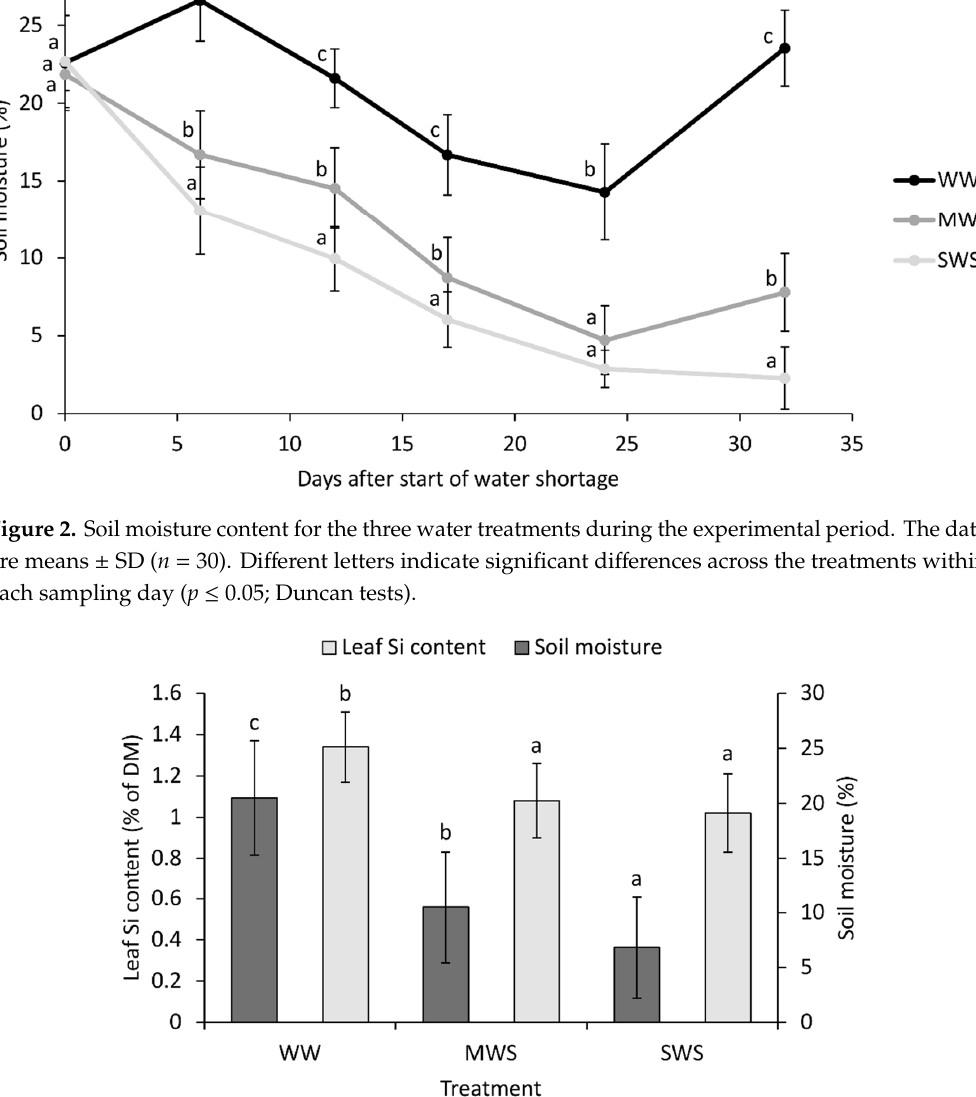
Figure 3. Proso millet leaf silicon (Si) content (sampled on day 32) and mean soil moisture (days 6, 12, 17, 24, 32) for the three water treatments. The data are means ± SD (Si, n = 5; soil moisture, n = 25). Different letters indicate significant differences within the Si and soil moisture measures across the treatments ( p ≤ 0.05; Duncan tests). DM, dry matter. Table 1. The proso millet leaf and plant parameters recorded under the different water treatments in this study.